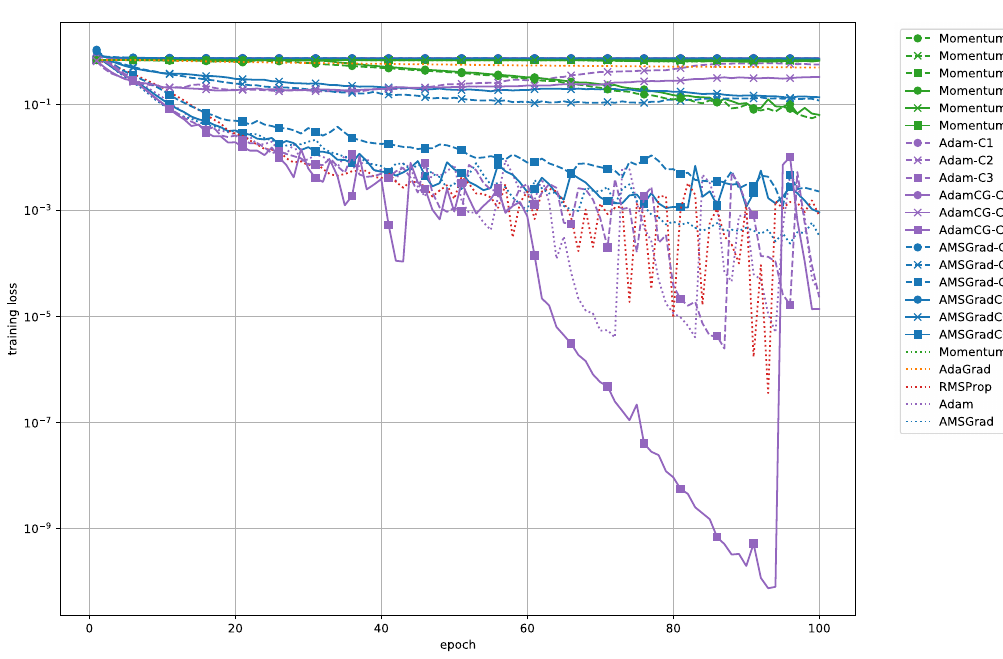
Figure 7. Loss function value versus number of epochs on the IMDb dataset for training (constant).